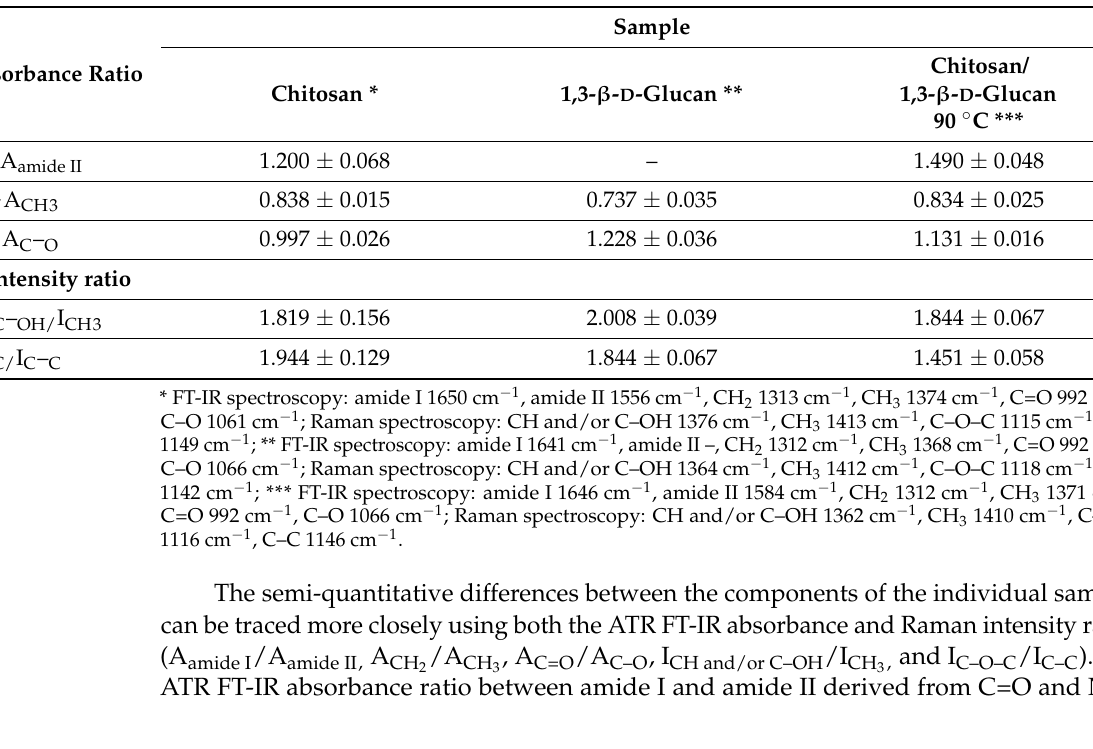
Table 3. Average calculated values of the ATR FT-IR absorbance and Raman intensity ratios for particular chemical groups detected in studied films. The results are presented as mean ± standard